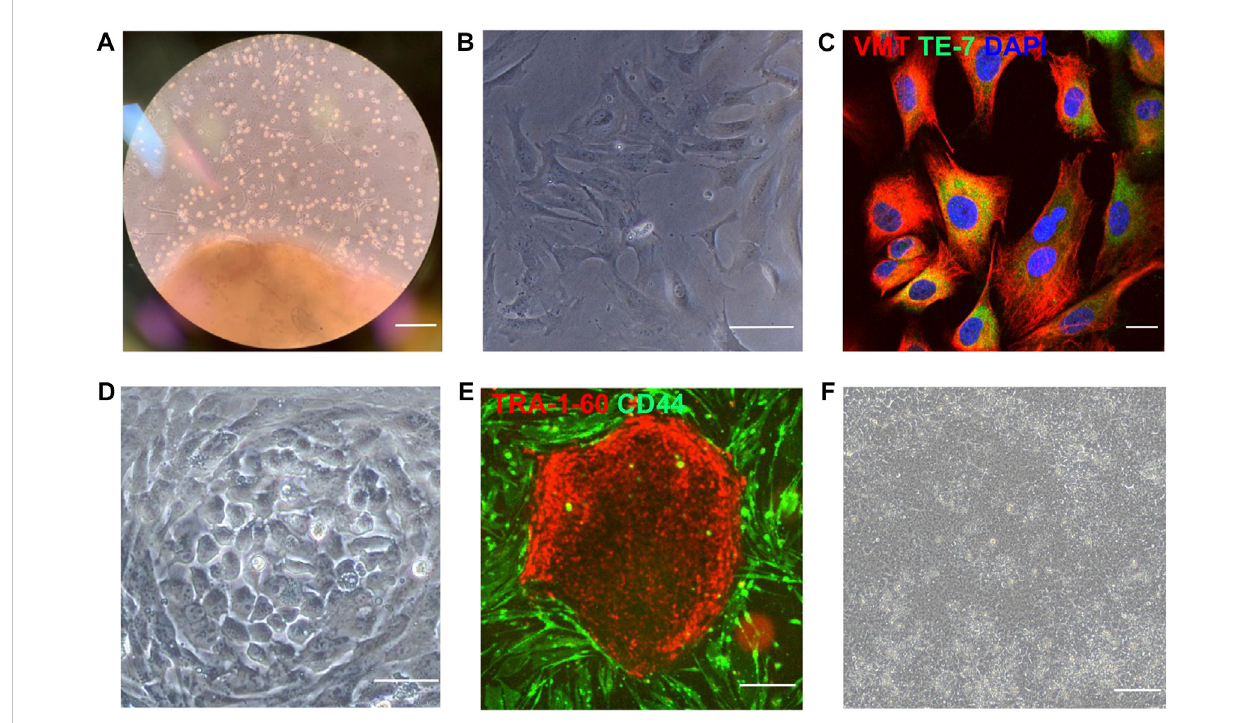
FIGURE 1 iPSCs were reprogrammed from human atrial and ventricular fi broblasts. (A) Cardiac tissue was obtained from the atrium and ventricle of a male newborninfantpatientwhounderwentopen-chestsurgeryford-TGAandculturedtoinduce fi broblastoutgrowth. (B) Isolated fi broblasts(bar=100 μ m) were (C) evaluated for expression of the fi broblast-speci fi c markers vimentin (VMT) and TE-7 via immuno fl uorescence staining (bar = 20 μ m) and then reprogrammed (D) into A iPSCand V iPSC via transfectionwithSendaiviruscodingforOCT4,SOX2,KLF4,andC-MYC(bar=100 μ m). (E) Three weeks aftertransduction,putativehiPSCswereidenti fi ed via liveimmuno fl uorescentstainingforCD44andthepluripotencymarkerTra1-60(bar=200 μ m)and (F) imaged for morphological assessments (bar = 100 μ m). Representative images of cultured ventricular tissue (Panel A), ventricular fi broblasts (B – C) , and V iPSC (D – F) are